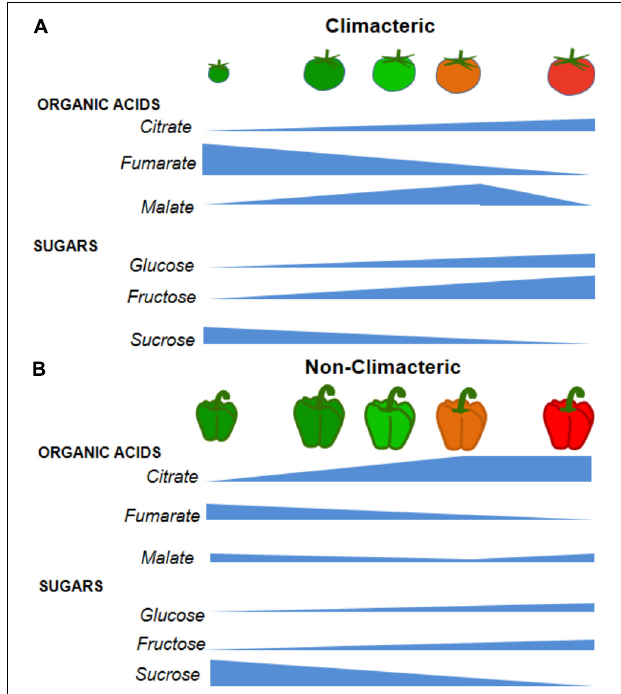
FIGURE 1 | Comparative metabolite accumulation during fruit growth in two significant examples of climacteric (tomato, Solanum lycopersicum ) and non-climacteric (pepper, Capsicum spp.) species. (A) Organic acids and sugars changes that occur in climacteric fruits during different stages of development and ripening using tomato fruit as a model of climacteric fruit. The concentration of each metabolite is dependent on the metabolic intensity and the time of development of the fruit with major changes during the climacteric peak phase (approximately 35 days after anthesis). (B) Organic acids and sugar changes that occur in non-climacteric fruit during different stages of development and ripening using pepper as a model. Although lacking a climacteric peak, fruits considered non-climacteric present metabolite profile alterations during maturation, but with lower intensities than in climacteric